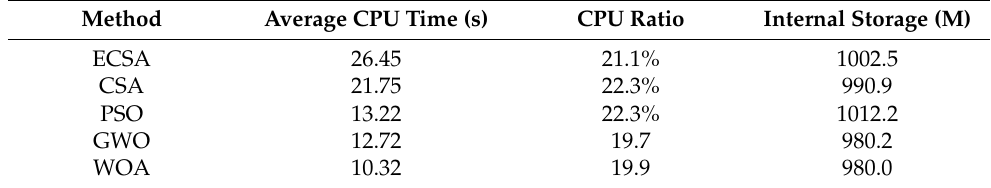
Table 11. Running time comparison.